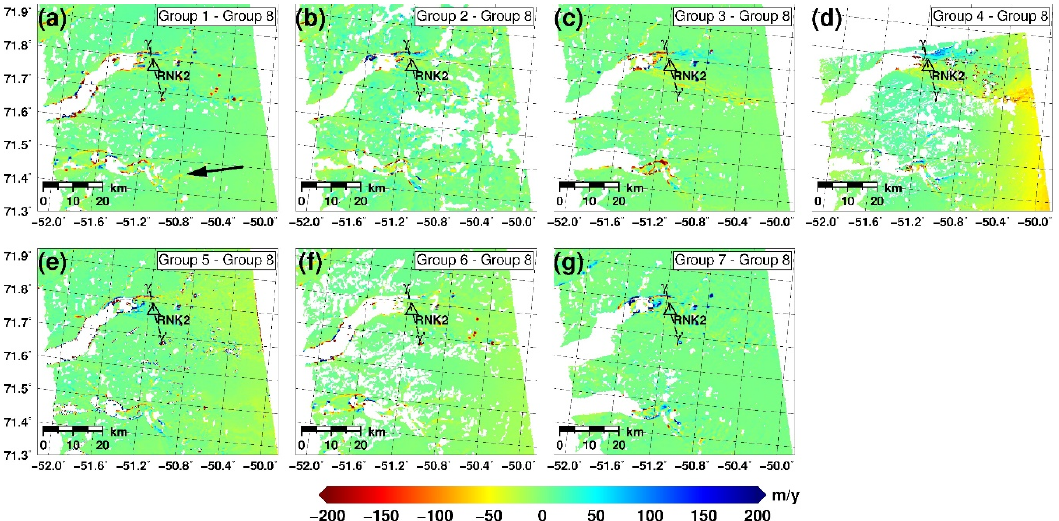
Figure 19. Task 4 LoS velocity differences between groups 1 to 7 ( a – g ) with respect to group 8 in the area of RNK2 GPS station. The dashed lines represent the trace of the profiles in Figure 24e.